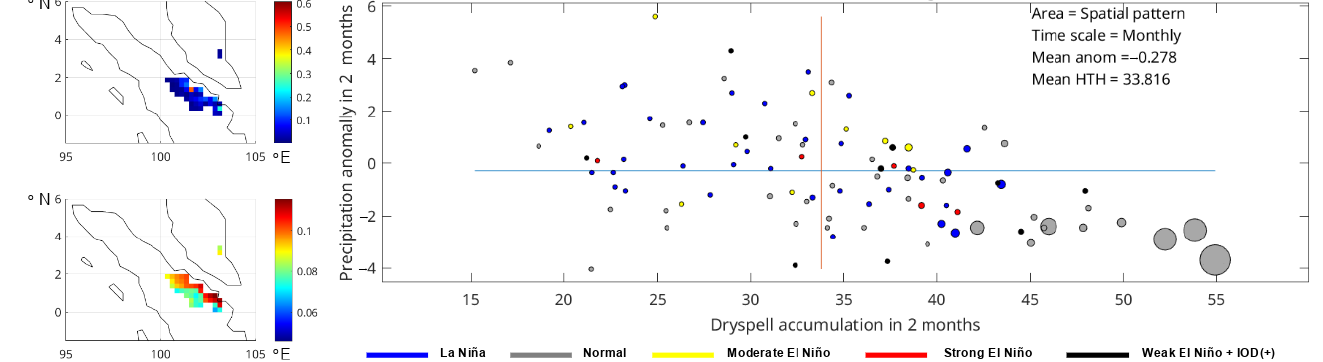
Figure 6. Early year dry season of northern Sumatra—spatial graph of hotspots ( top ) and dry spells ( bottom ) as well as bubble plot of the monthly fire events for all categories. Blue and orange lines represent average value of respective variables. Size of the bubble represents the number of hotspots for each particular month. Extracted from first mode of SVD with 95.5% of SCF value.